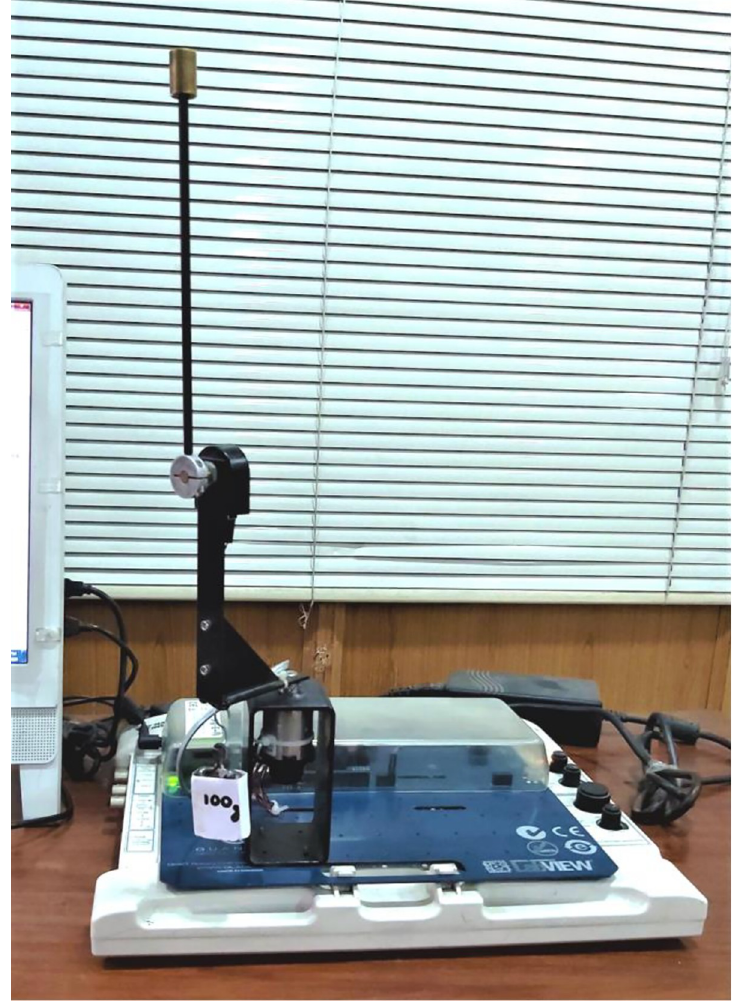
Fig 11. The QNET Rotary Pendulum’s hardware